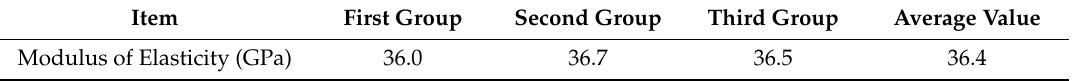
Table A7. Elastic modulus obtained from the experimental test on C60 HPC.